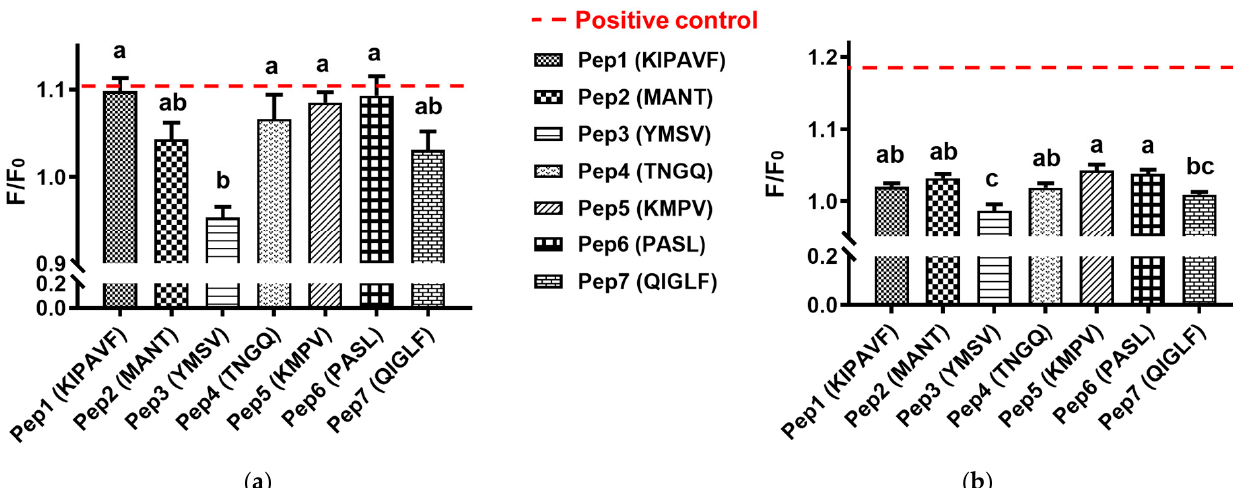
Figure 3. ( a ) Soluble mucin-binding activity of peptides; positive control value was 1.100 ± 0.019. Different letters indicate significantly different mean values ( p < 0.05); ( b ) Whole mucin-binding activity of peptides; positive control value was 1.175 ± 0.028. Different letters indicate significantly different mean values ( p <